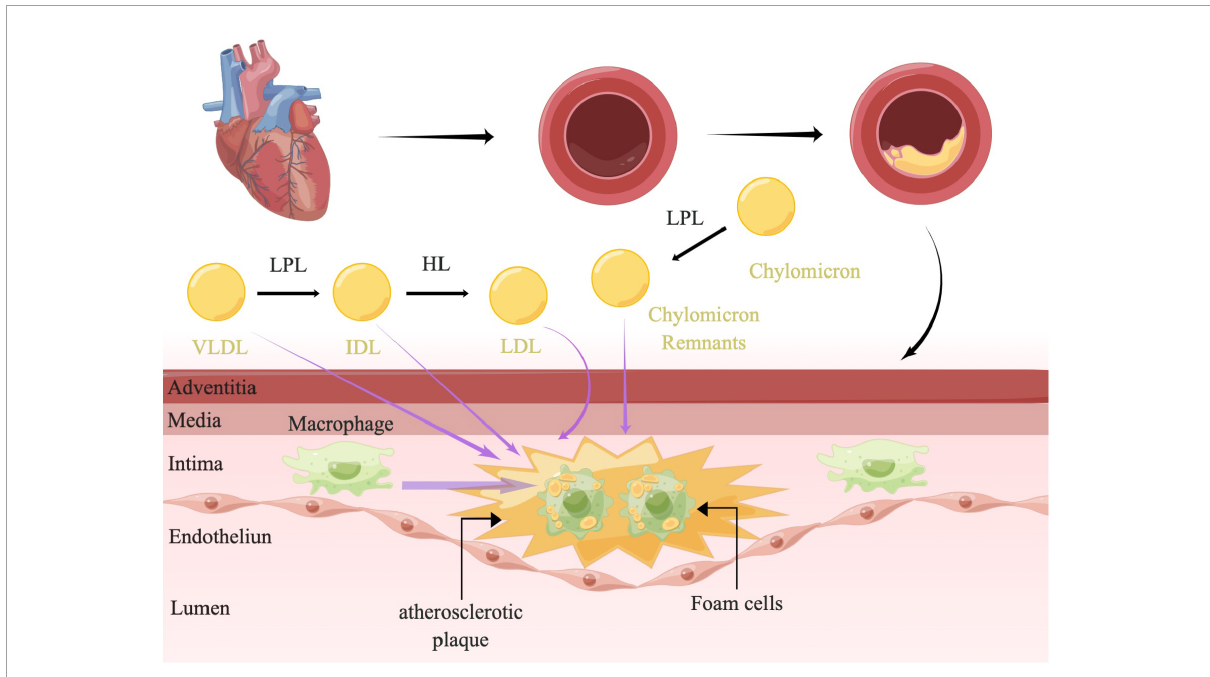
FIGURE3 The mechanism of atherosclerosis. LPL along the capillary lumen surface hydrolyzed VLDL, resulting in VLDL remnants/IDL particles and lipolysis products. The IDL particles were further catabolized into LDL by HL. LPL could also hydrolyzed chylomicrons to produce chylomicron remnants. TRLs and their remnants readily penetrate the arterial wall and can be taken up by scavenger receptors on macrophages directly without oxidative modification, leading to formation of foam cells and atherosclerotic plaque development. TRLs, triglyceride-rich lipoproteins; LPL, lipoprotein lipase; HL, hepatic lipase; VLDL, very-low-density lipoprotein; IDL, intermediate-density lipoprotein; LDL, low-density lipoprotein; RC, remnant